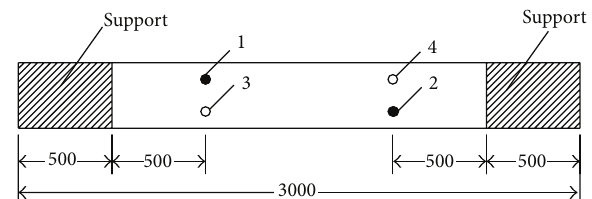
Figure 4: The arrangement of AE sensors mounted on surface of two sides of